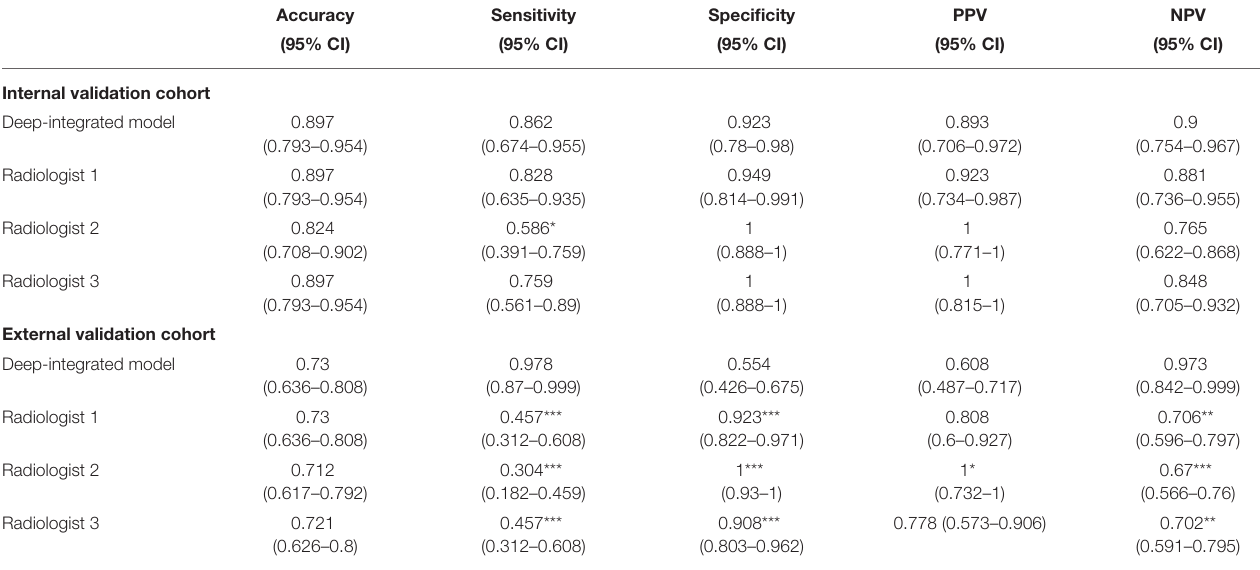
TABLE 6 | Performance comparison of the model and radiologists in the detection of AD.